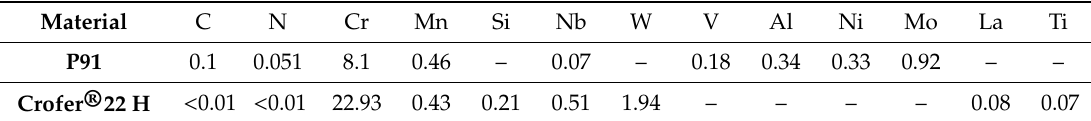
Table 1. Chemical compositions in wt.% of P91 and Crofer ® 22 H.